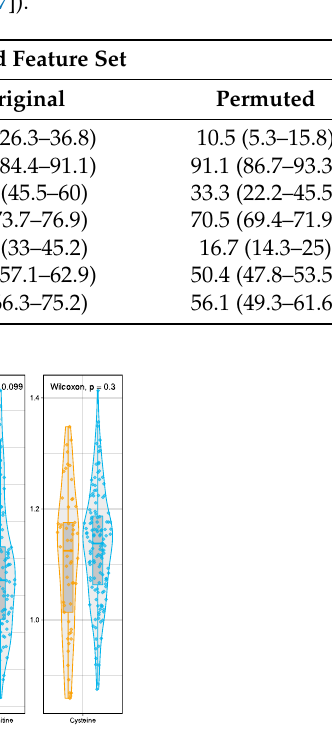
Table 2. Performance measures for assigning subjects to the two clusters previously found in the pain patients [13], of which cluster #1 includes patients with comparatively few body areas in pain, low interference, little sleep disturbance, and low blood pressure. The performance of machine-learning- based random forest classifiers is given; for further algorithms, the selected main performance criterion (balanced accuracy) is shown in Supplementary Figure S2. Classification performance was measured (i) with the original data, (ii) with data sets designed to provide negative control by permutation of the original metabolomic parameters, and then with original or permuted data of those seven metabolomic markers found relevant to the patient subgrouping after feature selection (Figure 3). Results represent the medians (IQRs in parentheses) of the test performance measures from 1000 model runs using Monte Carlo resampling. The parameters correspond to the performance marker set implemented in the R libraries “caret” (https://cran.r-project.org/package=caret [26])